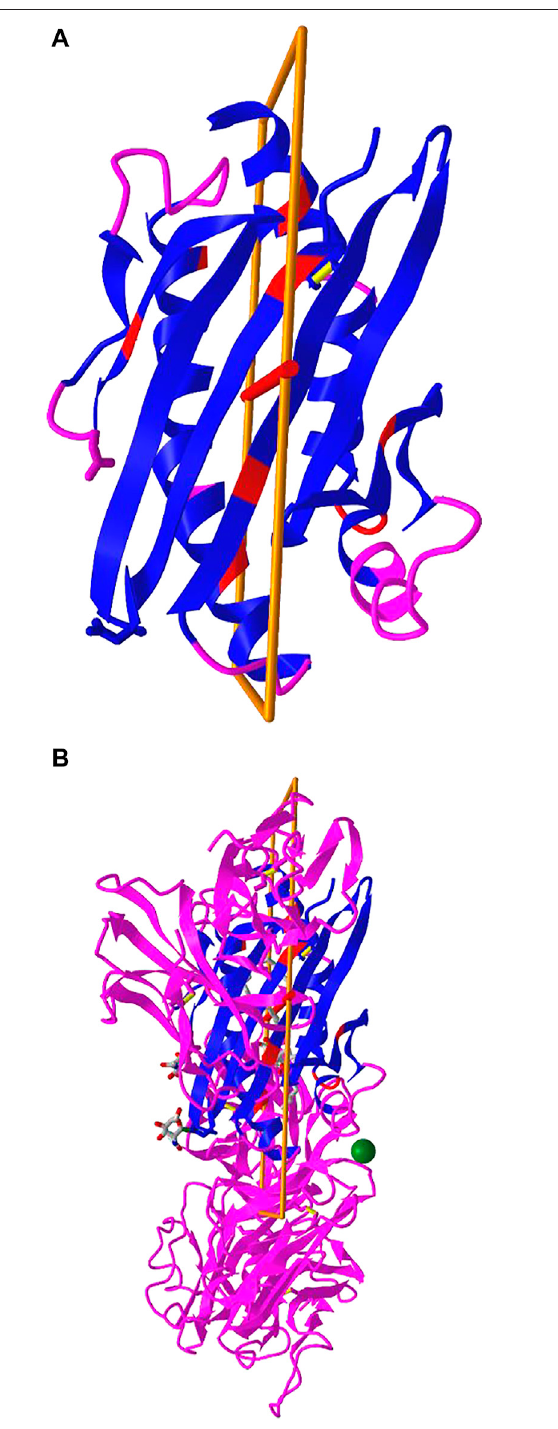
FIGURE 5 | Dynamic symmetry calculation. (A) The subset of residues 1-178 in the A chain of PDB 3HUJ was used for symmetry calculation. The symmetric parts are colored in red (same residue) or blue (different residues). The rest are colored in pink. (B) The full structure of PDB 3HUJ with the symmetry in Chain Ashown. Sharable link: https://structure.ncbi.nlm.nih.gov/ icn3d/share.html?gNe7MemEb5vqYSba6.